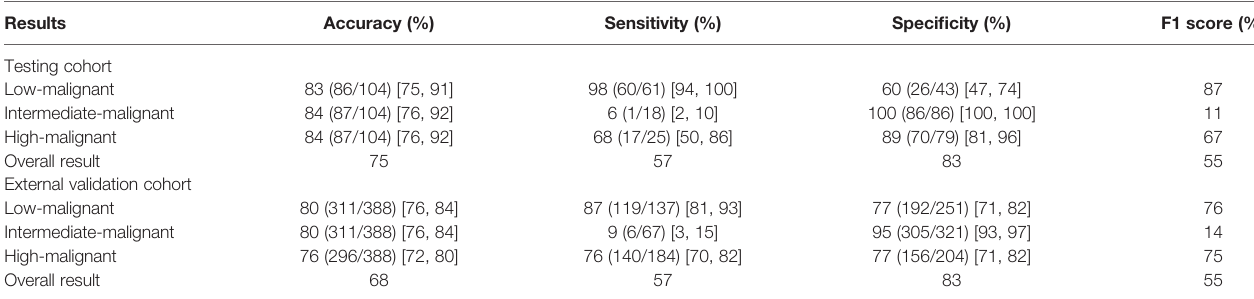
TABLE 3 | Predictive performance of radiomics model in the testing and external validation